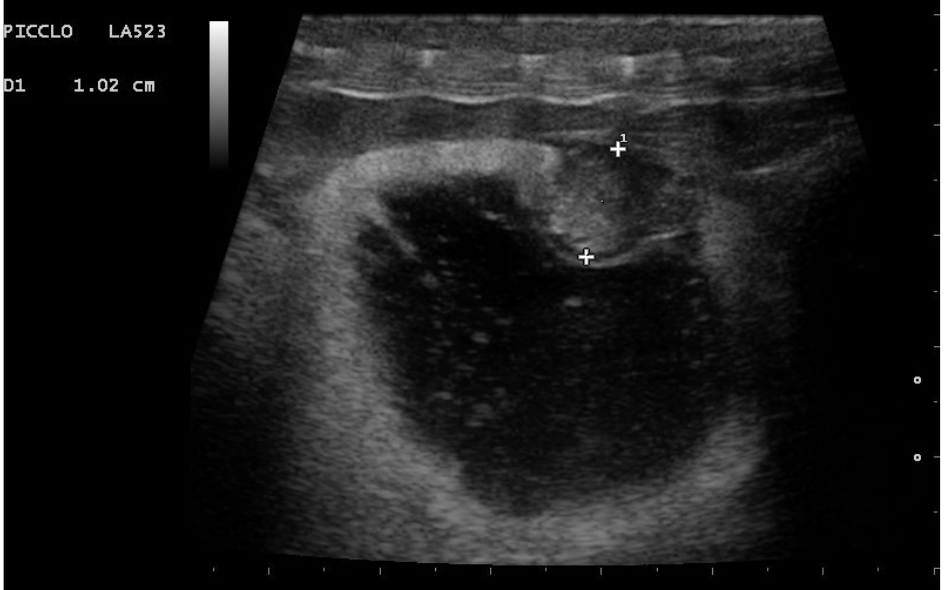
Figure 11. Gravid female boa 42 days after ovulation. An embryonic vesicle 10.2 mm in diameter, surrounded by a large anechoic area, is clearly visible. The outer membrane is instead hyperechoic. Phase recognized in 100% of females who gave birth to live and viable offspring.